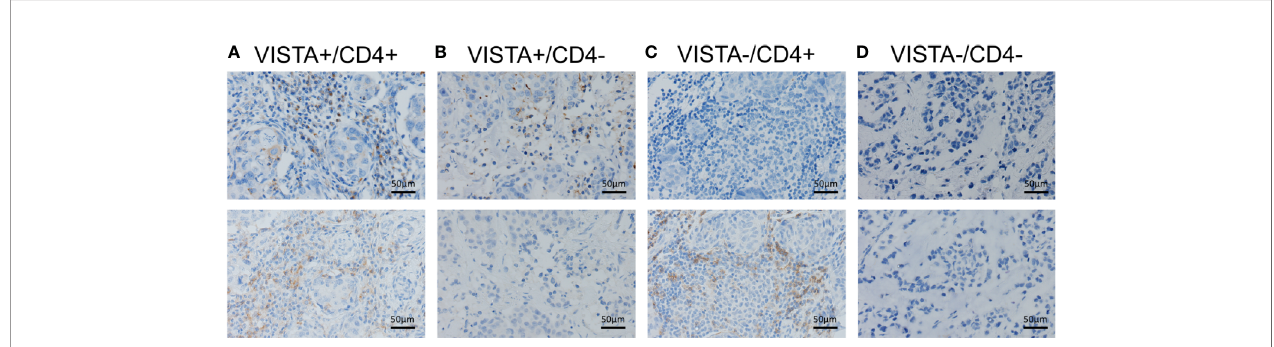
FIGURE 4 | Classi fi cation of the triple-negative breast cancer immune microenvironment according to the expression of V-domain Ig suppressor of T cell activation (VISTA) on immune cells and CD4 + tumor-in fi ltrating lymphocytes (TILs). (A) VISTA+/CD4+. (B) VISTA+/CD4-. (C) VISTA-/CD4+. (D) VISTA-/CD4-.